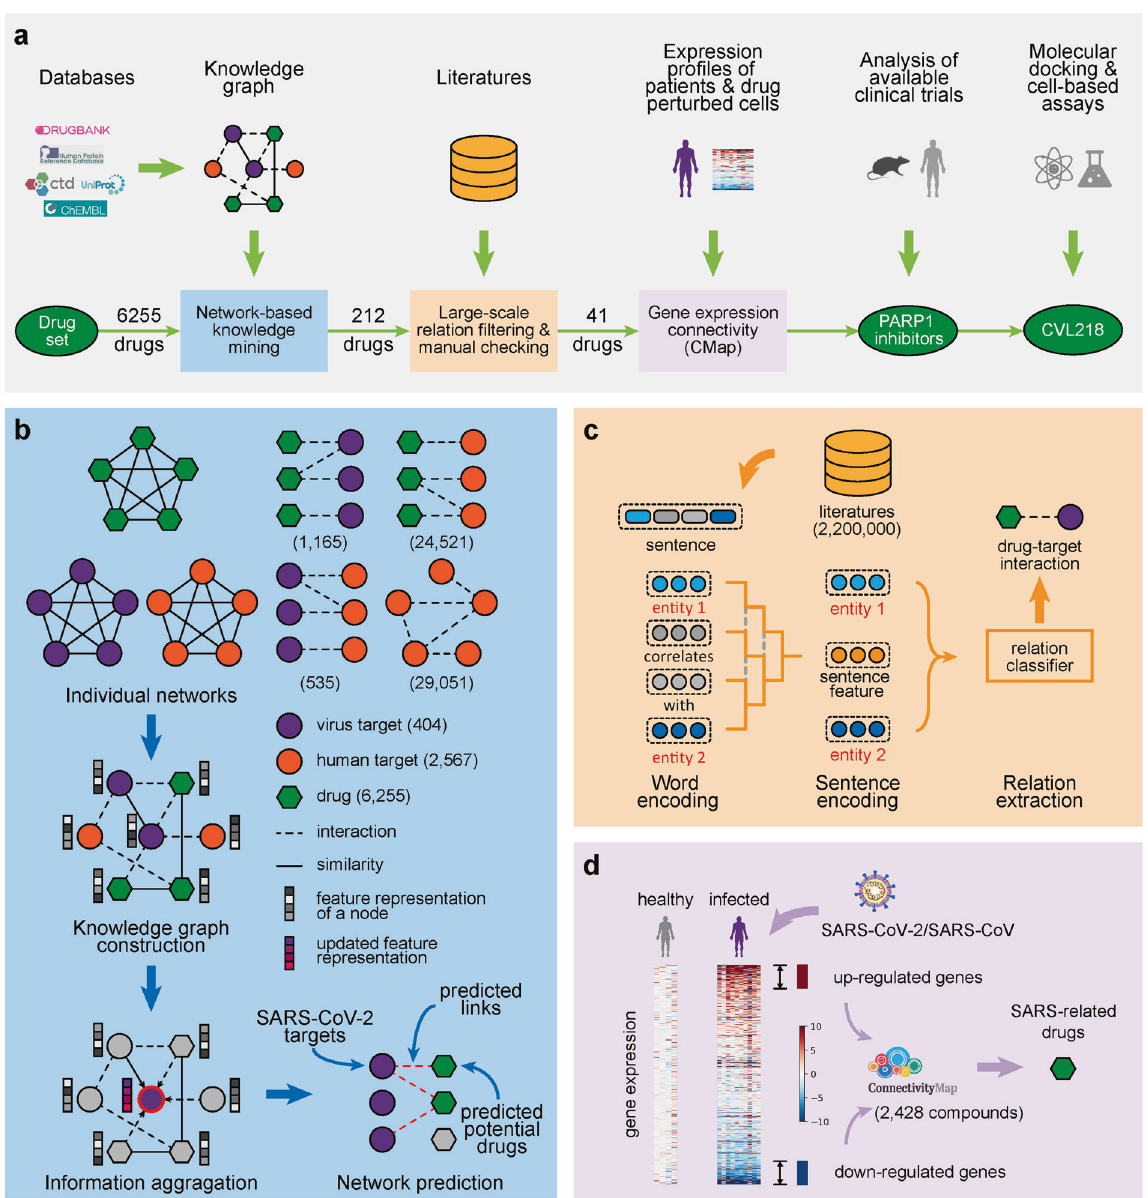
Fig. 1 Schematic illustration of our integrative drug repositioning pipeline for discovering the potential drugs to treat the COVID-19 disease. a The overview of our drug screening pipeline. The initial drug set for screening contains 6255 drug candidates, mainly including 1786 approved, 1125 investigational, and 3290 experimental drugs. The number of drug candidates after each fi ltering step is also shown. Knowledge graph: a network containing entities (e.g., drugs and targets) and their relations. b The network-based knowledge mining module. Seven individual networks containing three types of nodes (i.e., drugs, human targets and virus targets) and the corresponding edges describing their interactions, associations or similarities are fi rst constructed based on the known chemical structures, protein sequences and relations derived from publically available databases. Then a deep learning based method, which learns and updates the feature representation of each node through information aggregation, is used to predict the potential drug candidates against a speci fi c coronavirus. c The automated relation extraction module. The structure of each sentence from the literature texts is fi rst learned from the encoded word features using the Gumbel tree gated recurrent unit technique. 4,96 Then the learned sequence structures as well as the corresponding encoded word features are fed into a relation classi fi er to automatically extract the relations between two entities from large-scale documents in the literature. d The connectivity map (CMap) analysis module. The transcriptome pro fi les of the peripheral blood mononuclear cell (PBMC) or the bronchoalveolar lavage fl uid (BALF) samples from the SARS-CoV-2 or SARS-CoV infected patients and healthy persons are compared to derive the query gene expression signatures, which are then correlated to the drug-perturbed cellular expression pro fi les in the connectivity map 5 to fi lter out the anti-SARS-CoV-2 drug candidates. For transcriptome data of SARS-CoV-2 infected cells, PBMC samples were provided by three patients and three healthy volunteers, and BALF samples were collected from three patients and two healthy volunteers. For transcriptome data of SARS-CoV infected cells, PBMC samples from ten patients and four healthy volunteers were included in our analysis